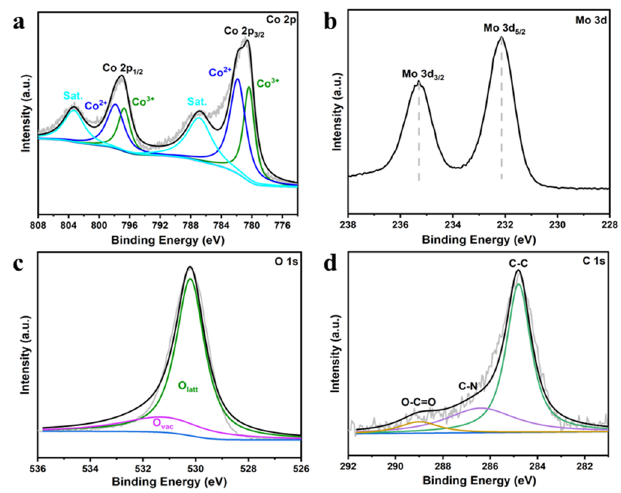
Figure 5. XPS spectra of ( a ) Co 2p; ( b ) Mo 3d; ( c ) O 1s; ( d ) C 1s of CMO-8. CMO-8 samples were heated from 40 °C to 800 °C under an air/N 2 flow of 20 mL/min, and the heating rates were 10 °C/min. In order to eliminate systematic error, blank tests were performed before the experiment to provide the baseline, and repetitions